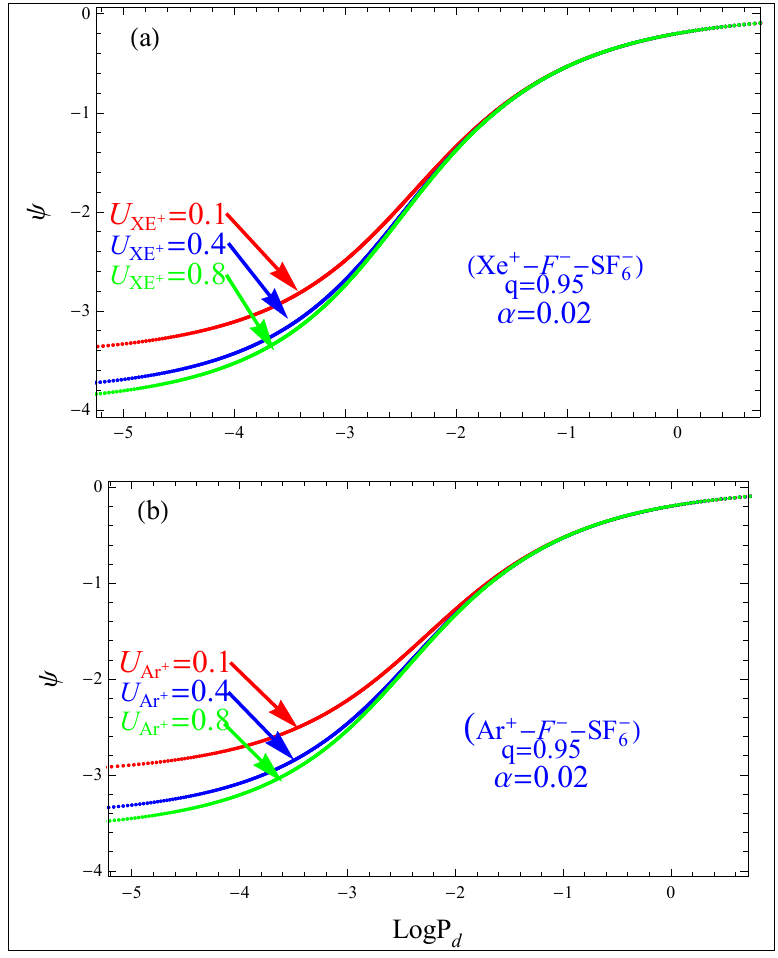
Figure 4. (Color online) ψ versus P d ( a ) for U Xe + ( 0.1,0.4.0.8 ) with q = 0.95 and α = 0.02, for xenon– fluorine–sulfur hexafluoride as given in Equation (10) ( b ) for U Ar + ( 0.1,0.4.0.8 ) with q = 0.95 and α = 0.02 for argon–fluorine–sulfur hexafluoride plasma as given in Equation